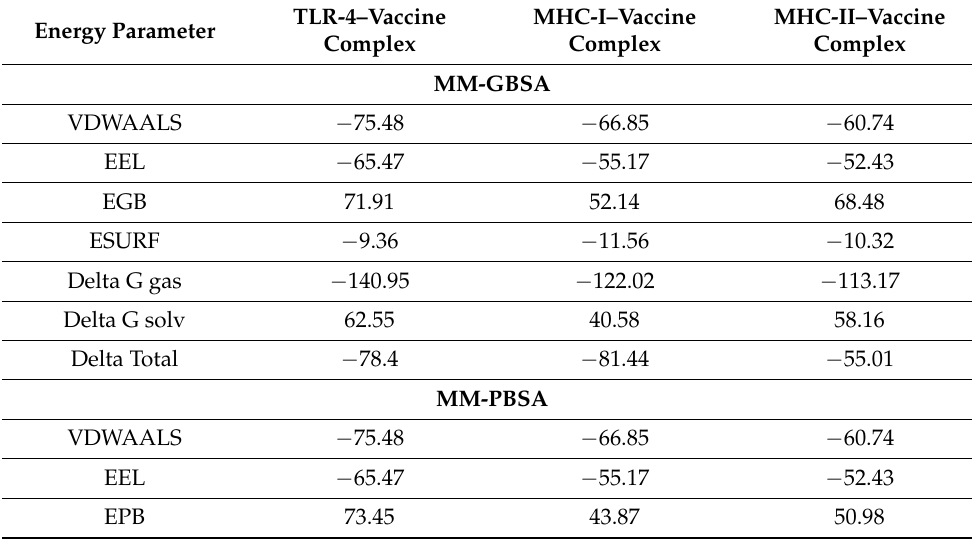
Table 4. MMGBSA/PBSA binding free energy results of the vaccine construct with MHC- I, MHC-II, and TLR4 complexes.